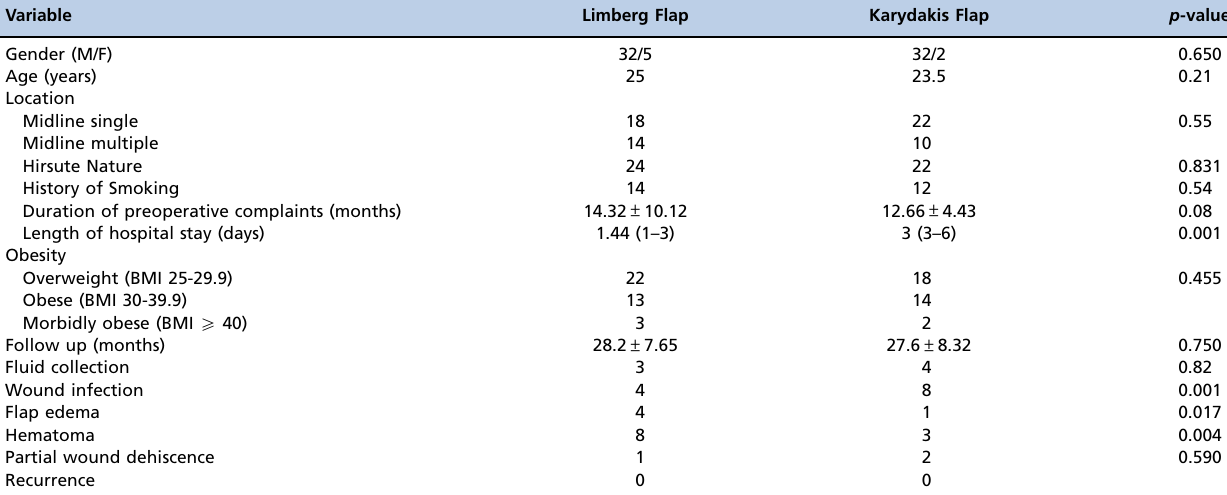
Table 1 - Clinical comparison, operative characteristics and complications between groups. Variable